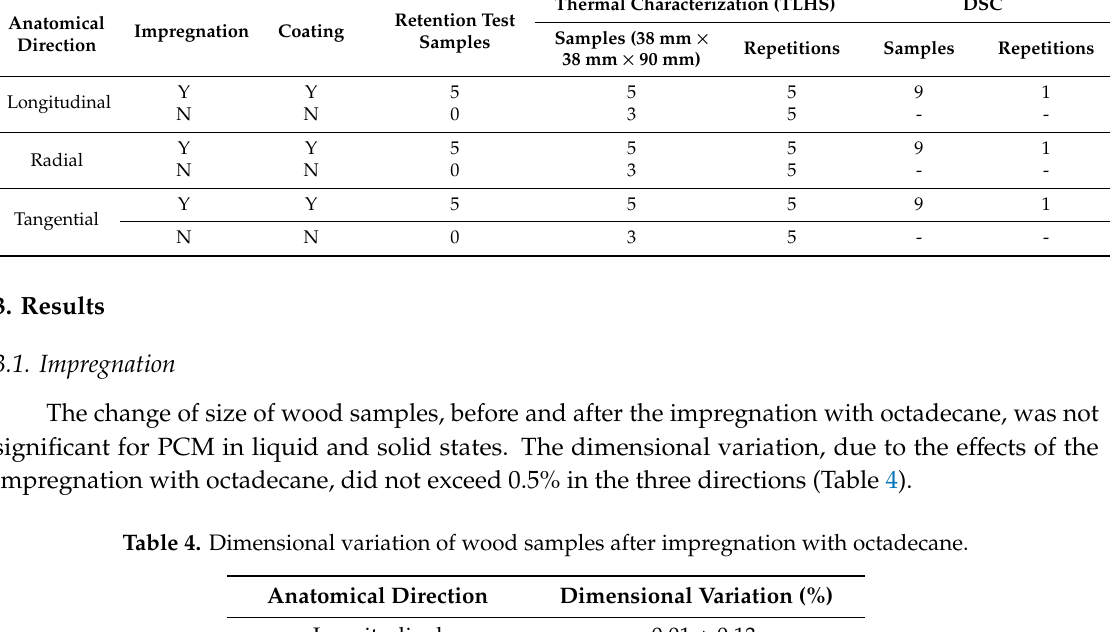
Table 4. Dimensional variation of wood samples after impregnation with octadecane.